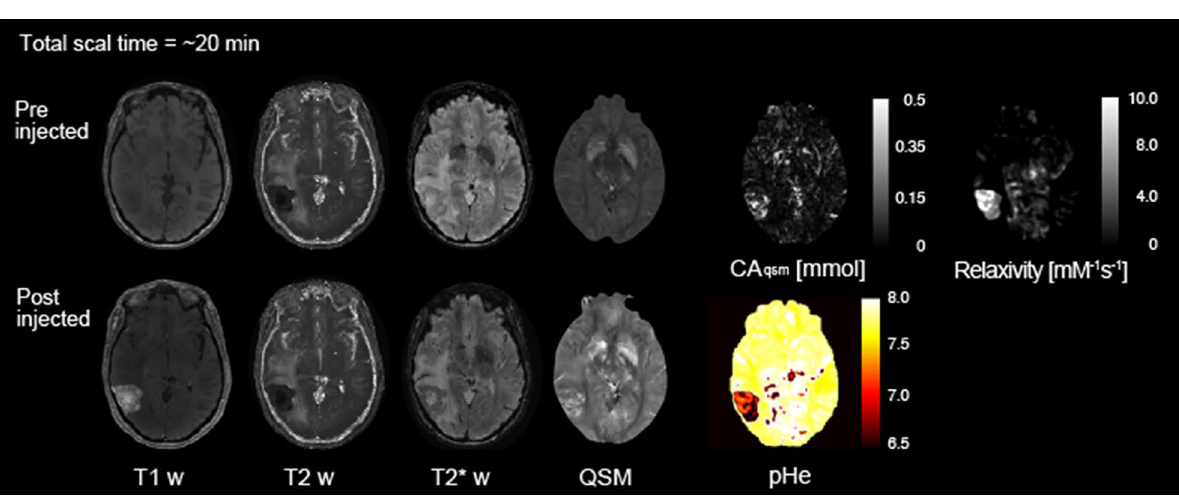
Figure 7. Brain disease evaluation using QPM before and after contrast agent injection. Simultaneous 3D mapping of PD, T1, T2* and susceptibility map can obtain contrast images. Moreover, our method can estimate CA concentration, r1 and pHe mapping by using